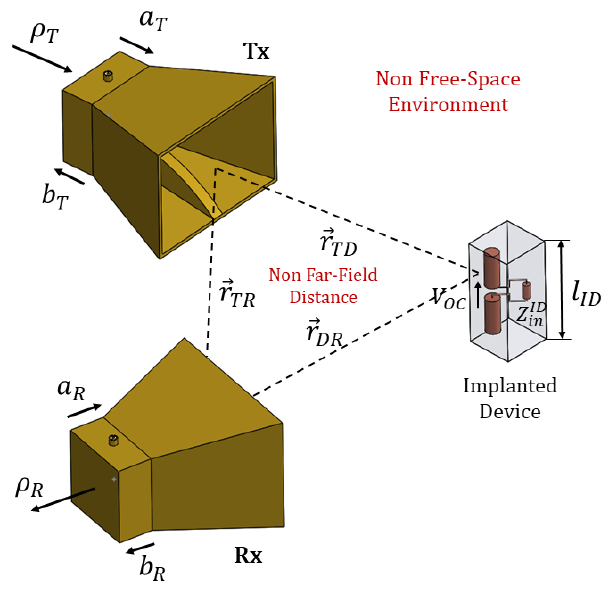
Figure 1. General